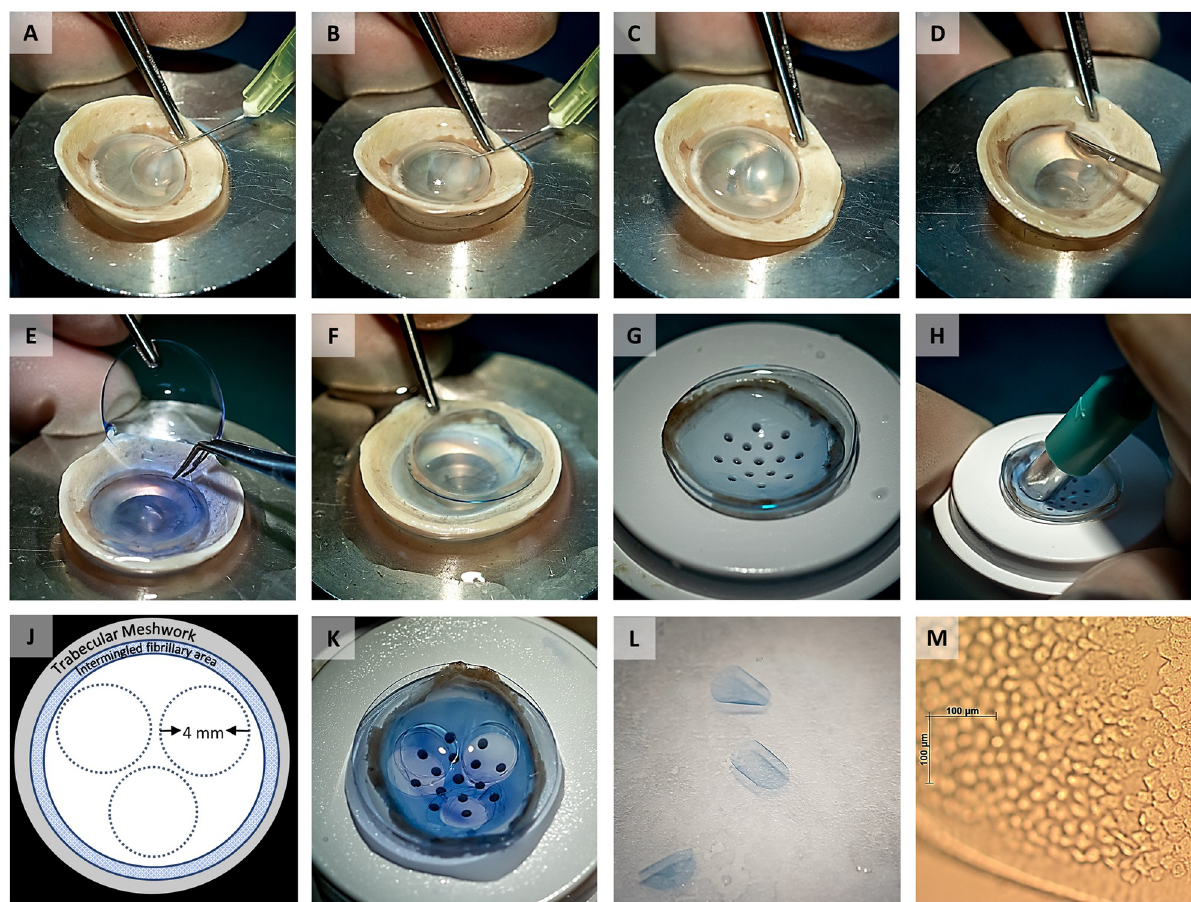
Fig 1. Image collage showing the different steps of preparing three small diameter grafts from one donor cornea. (A) Local DM separation from the stoma by hydro-dissection using a bent 30G needle. (B, C) Separation of the DM along with the corneal endothelium by a bubble spanning the full diameter of the cornea. (D) Complete detachment of the peripheral DM with its adjacent TM using a hockey stick blade. (E) The anterior remnant was replaced on a soft contact lens. (F, G) Transfer of the soft contact lens holding the DM with its TM to a punch block. (H) Preparation of three small diameter grafts by carefully punching out the grafts using a 4 mm diameter biopsy punch. (J) Schematic representation of the trephination pattern for the three grafts. (K, L) Remaining part of the DM sheet after punching out three 4mm grafts and the three resulting grafts. (M) Light microscopy image of a graft showing the endothelial cells on the graft and a very thin denuded band along the graft edge caused by trephination.